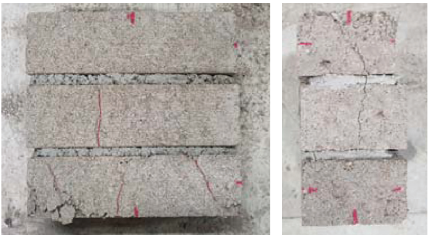
Figure 4: Typical failure mode of prism under compression.